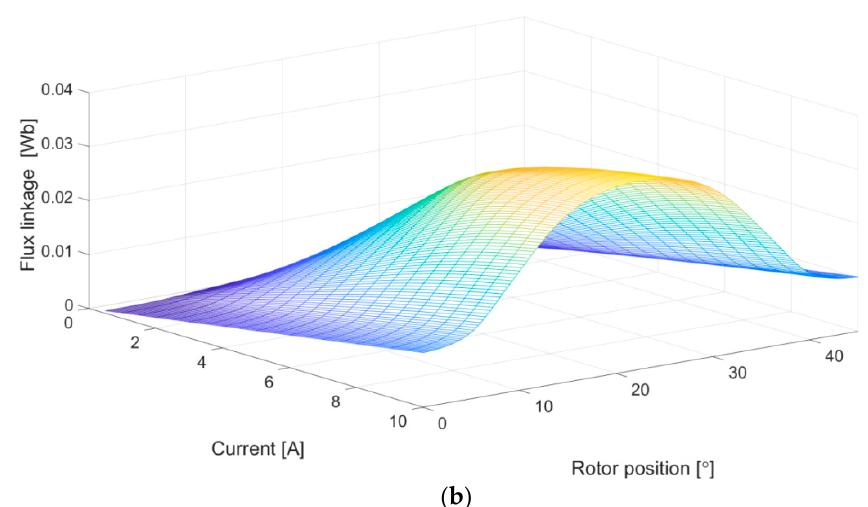
A ψ vs. rotor position θ and current i A vs. rotor position θ and current A 1 i : (a) DCBLDCM; (b) DCSRM. Figure 3. Flux linkage ψ A 1 1